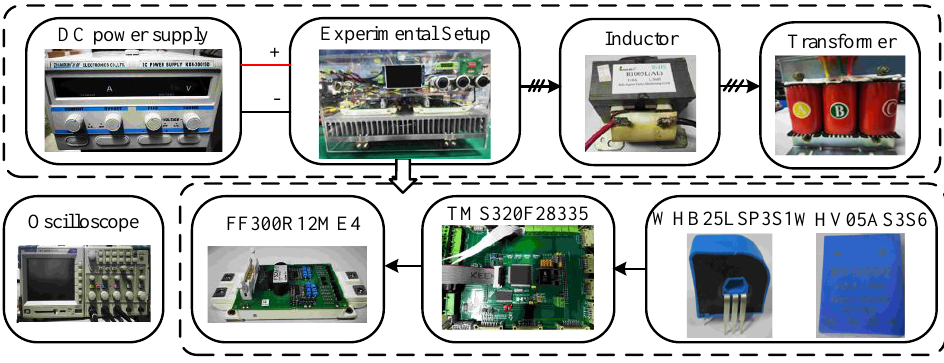
Figure 6. Experimental setup.